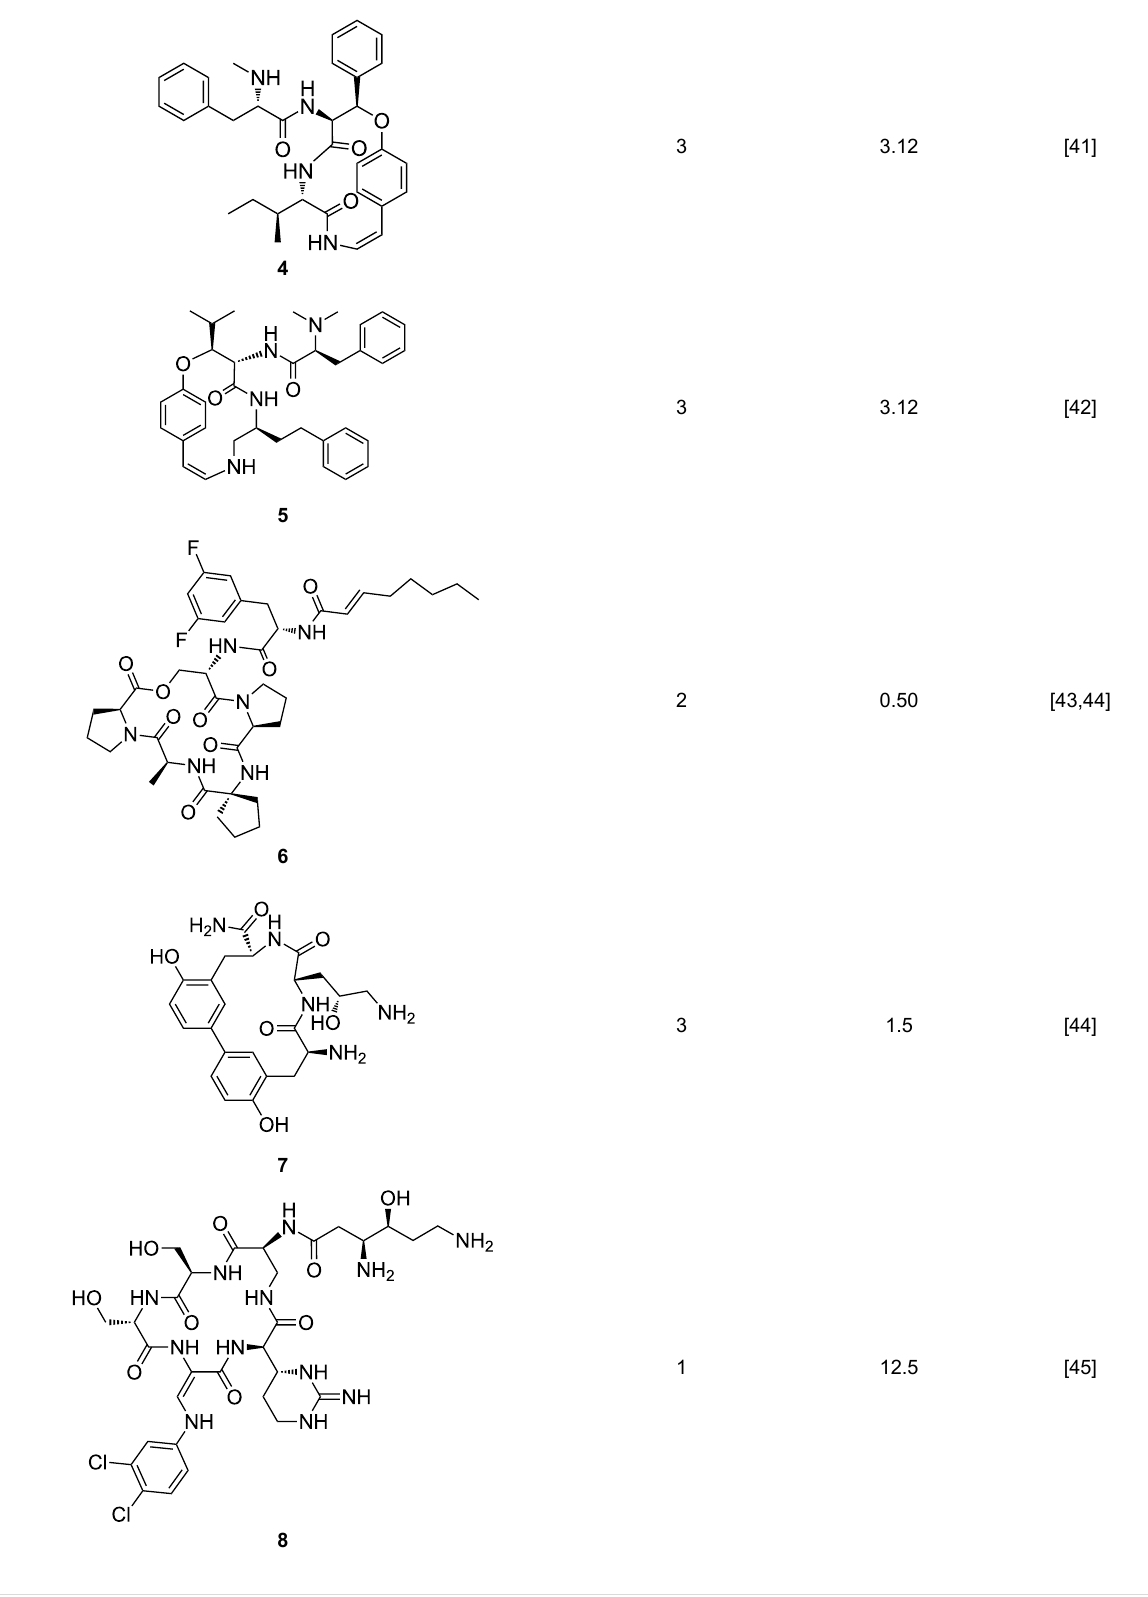
Table 1: Structures of cyclic peptides with their MIC values.